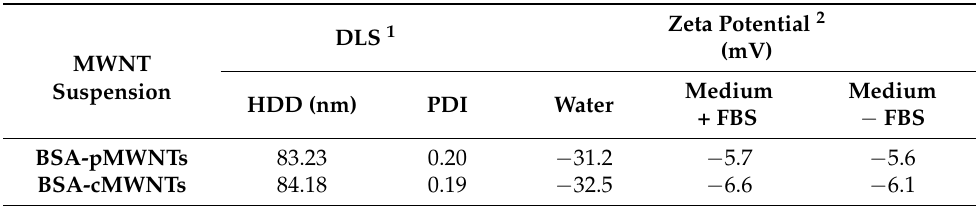
Table 1. Dynamic light scattering (DLS) particle size and zeta potential analyses of BSA-MWNT suspensions. DLS 1 MWNT Suspension